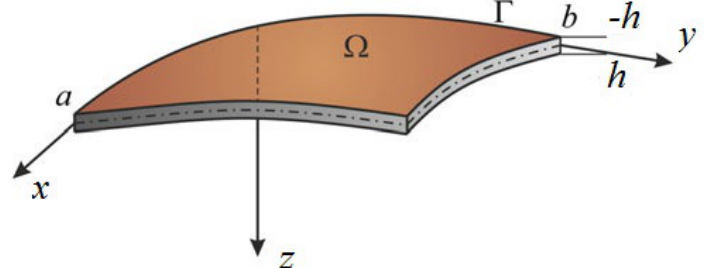
Figure 1. Computational shell scheme.